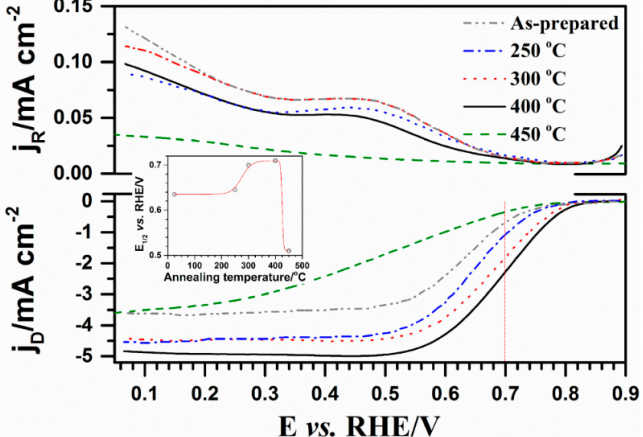
Figure 5. Ring (top) and disk (down) current density from RRDE measurements of 20 wt. % CoS/C samples after annealing at different temperature in O 2 -saturated 0.1 M KOH at 25 °C with a sweep rate of 5 mV s − 1 at a rotating speed of 2500 rpm. Inset shows the half-wave potential ( E 1/2 ) as a function of the annealing temperature. The CoS mass loading on the disk electrode is 80 μg·cm − 2